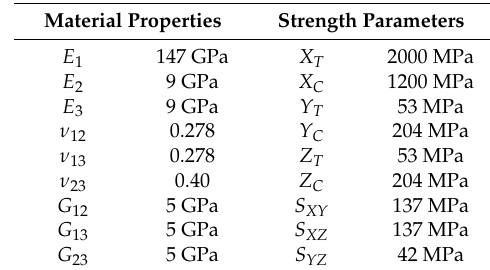
Table 4. Static material properties.